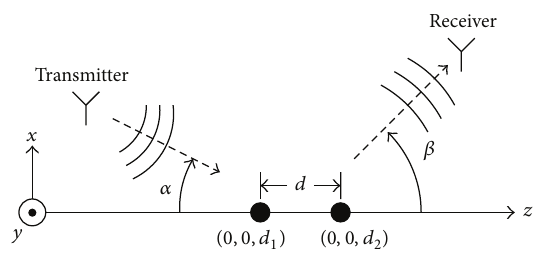
Figure 1: Conceptual illustration of the scattering